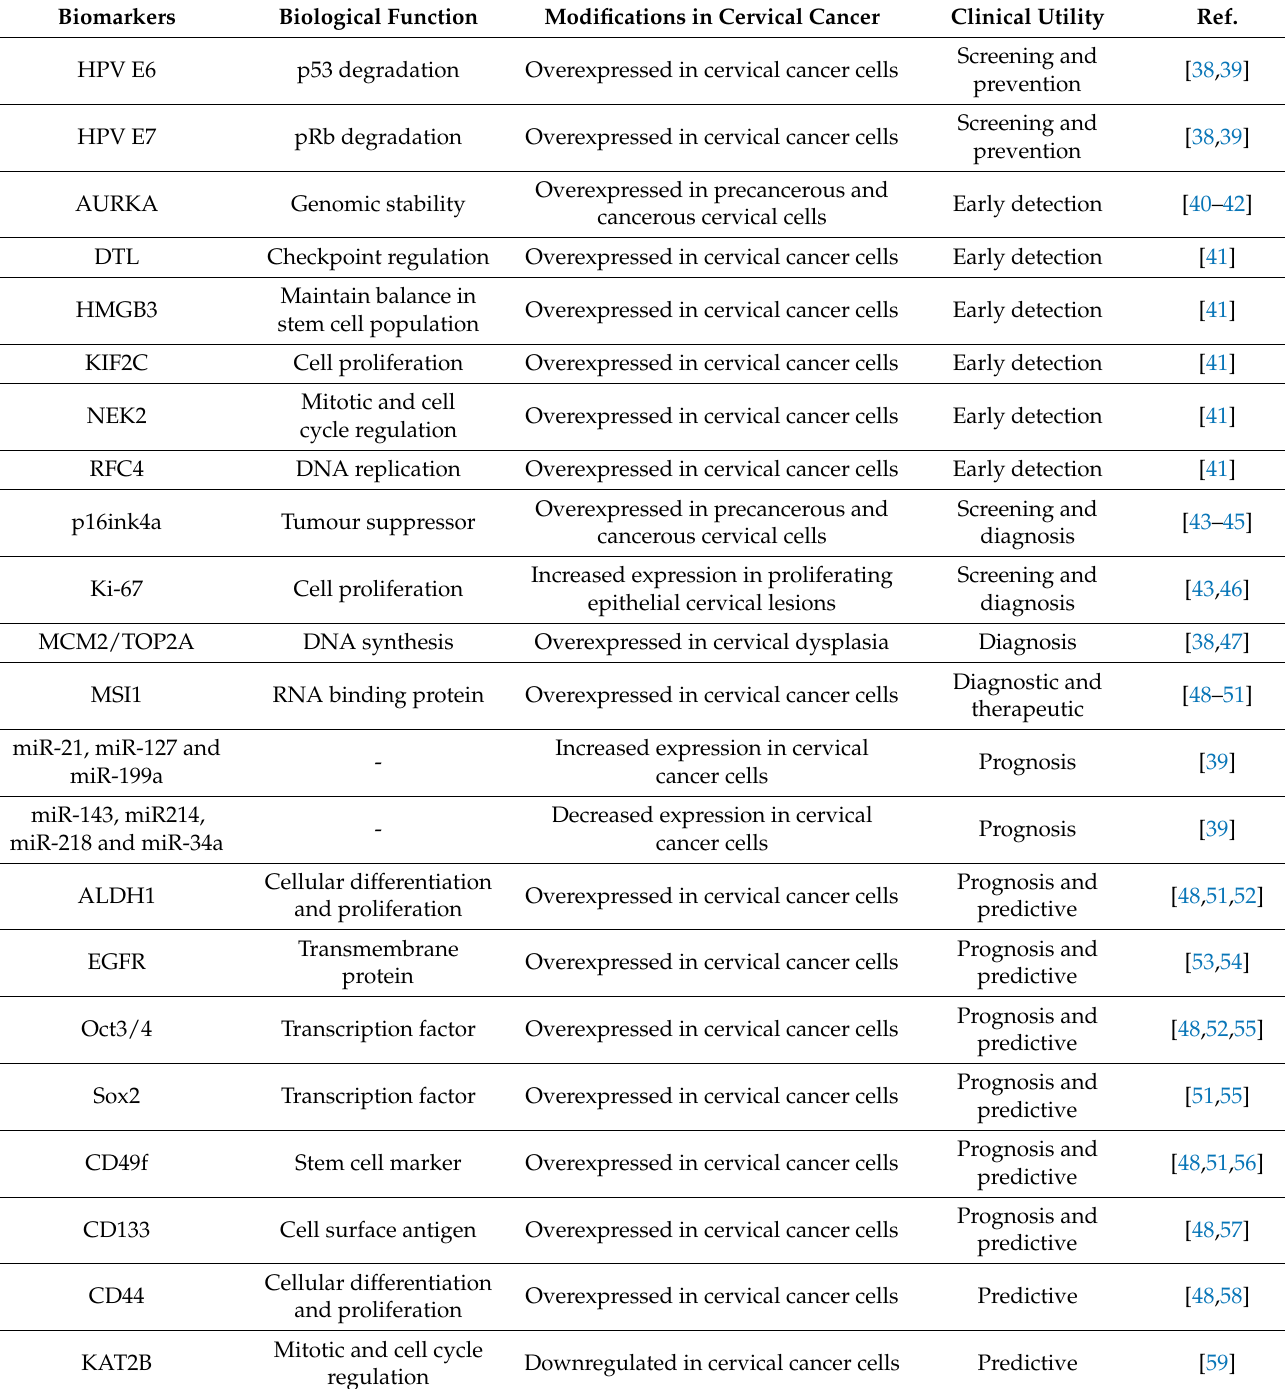
Table 1. Overview of biomarkers associated with cervical